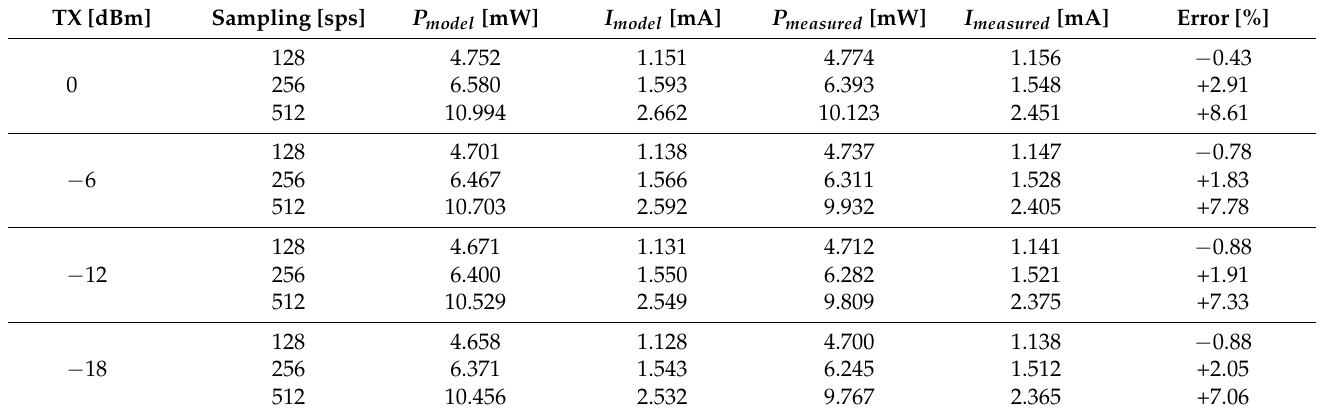
Table 5. Comparison of measured and model-based power and current consumption for active mode. Model error is expressed as percentage of the measured value.